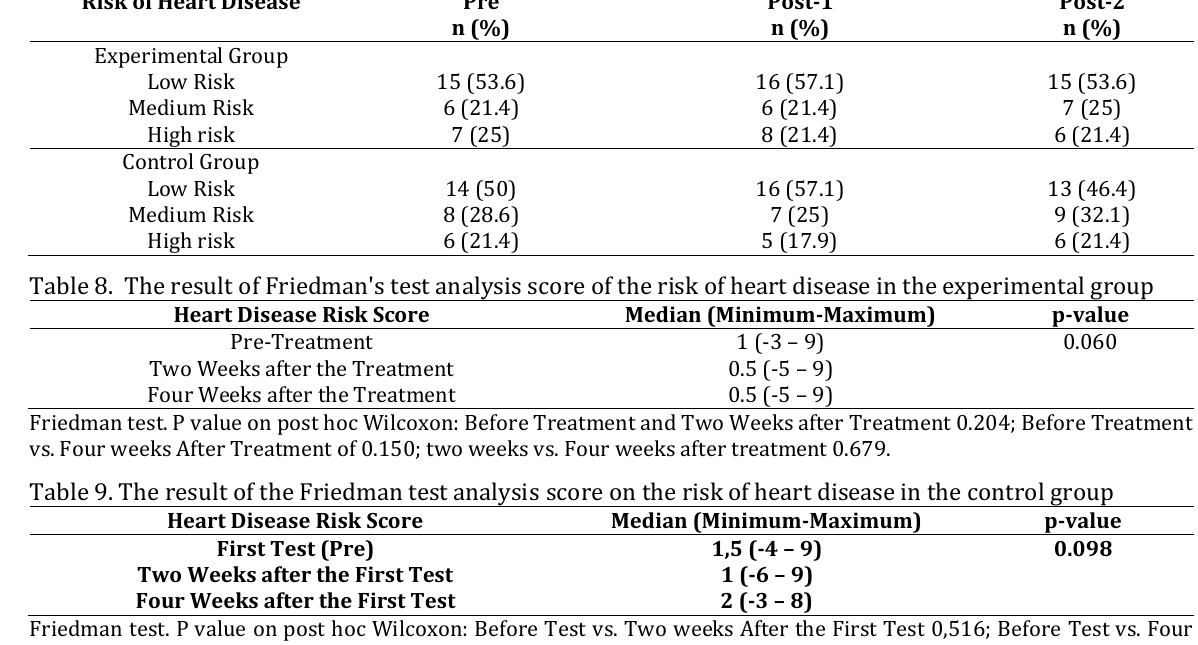
Table 7. Risk of heart disease in the experimental and control group Risk of Heart Disease